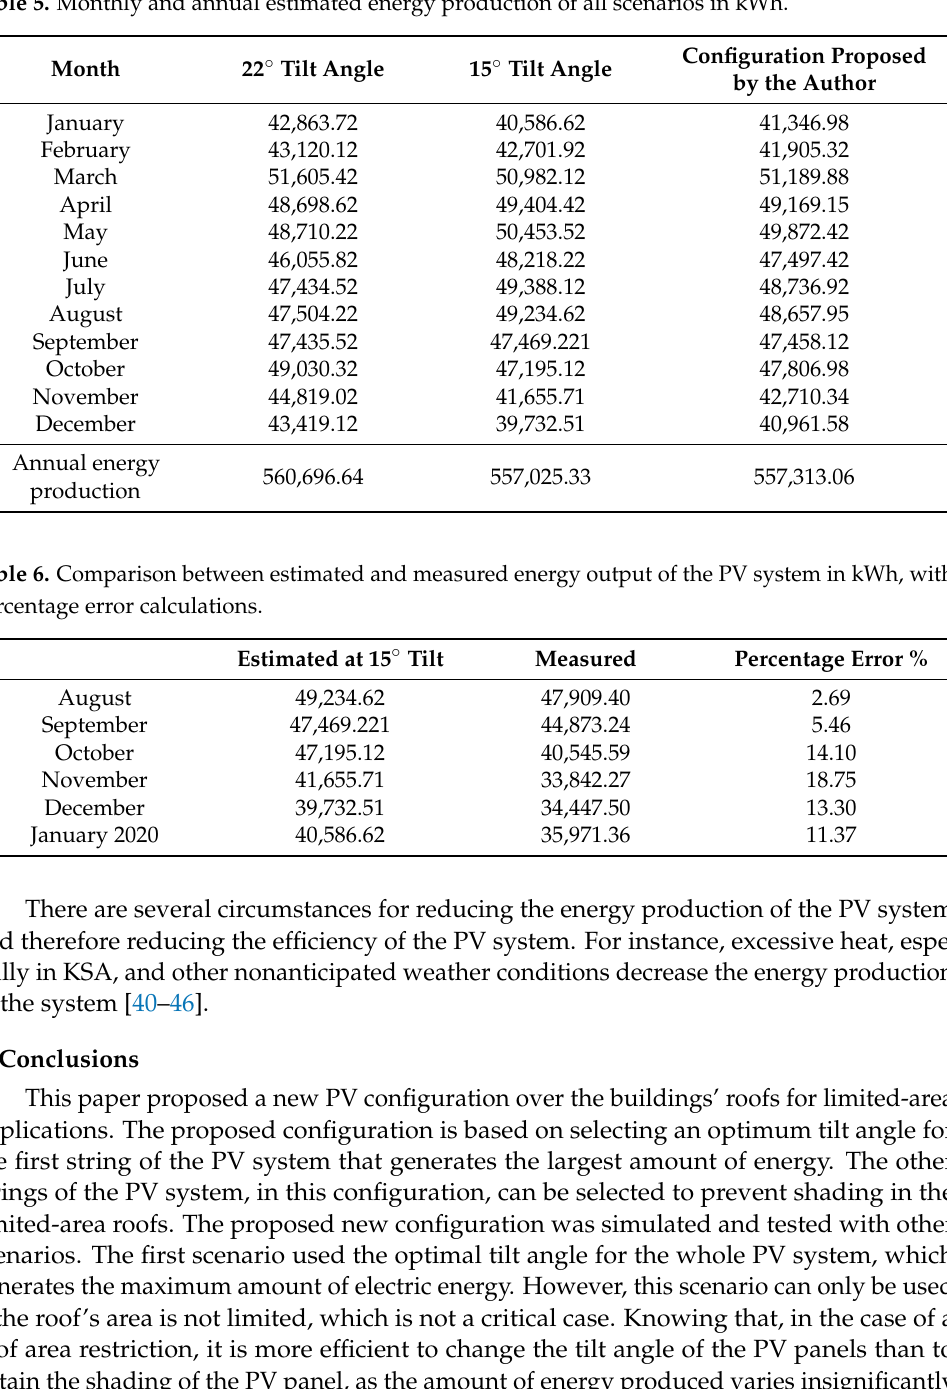
Table 5. Monthly and annual estimated energy production of all scenarios in kWh.